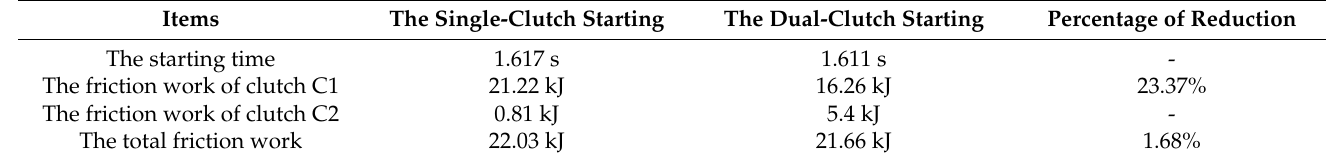
Table 5. The data of the simulation results of slowly starting.